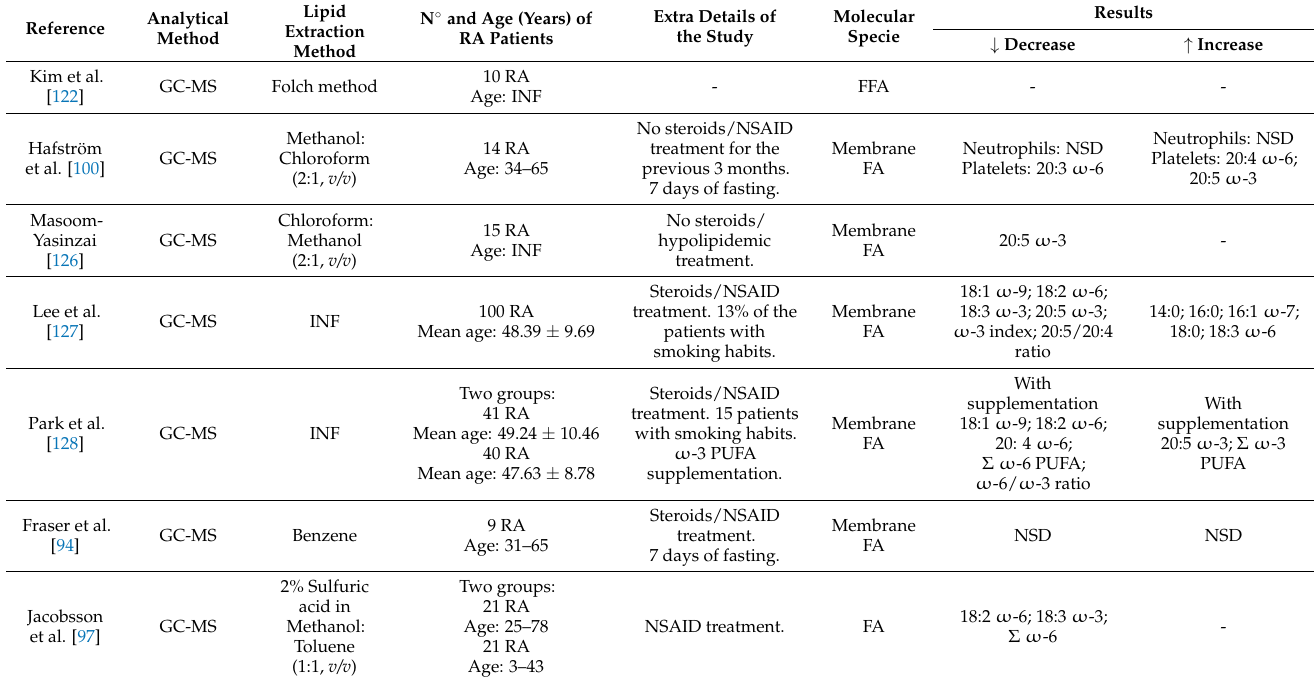
Table 2. Main lipid variations observed in synovial fluid [122], platelets [100], erythrocytes [126–128], neutrophils [100], PBMC [94], and adipose tissue [97] of RA patients reported in published lipidomic studies, available in PubMed database, using MS